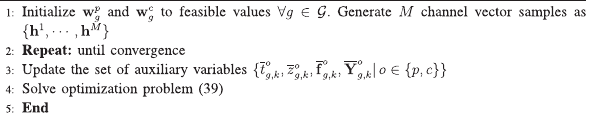
Algorithm 2 WMMSE-based Minimum Achievable Rate Maximization